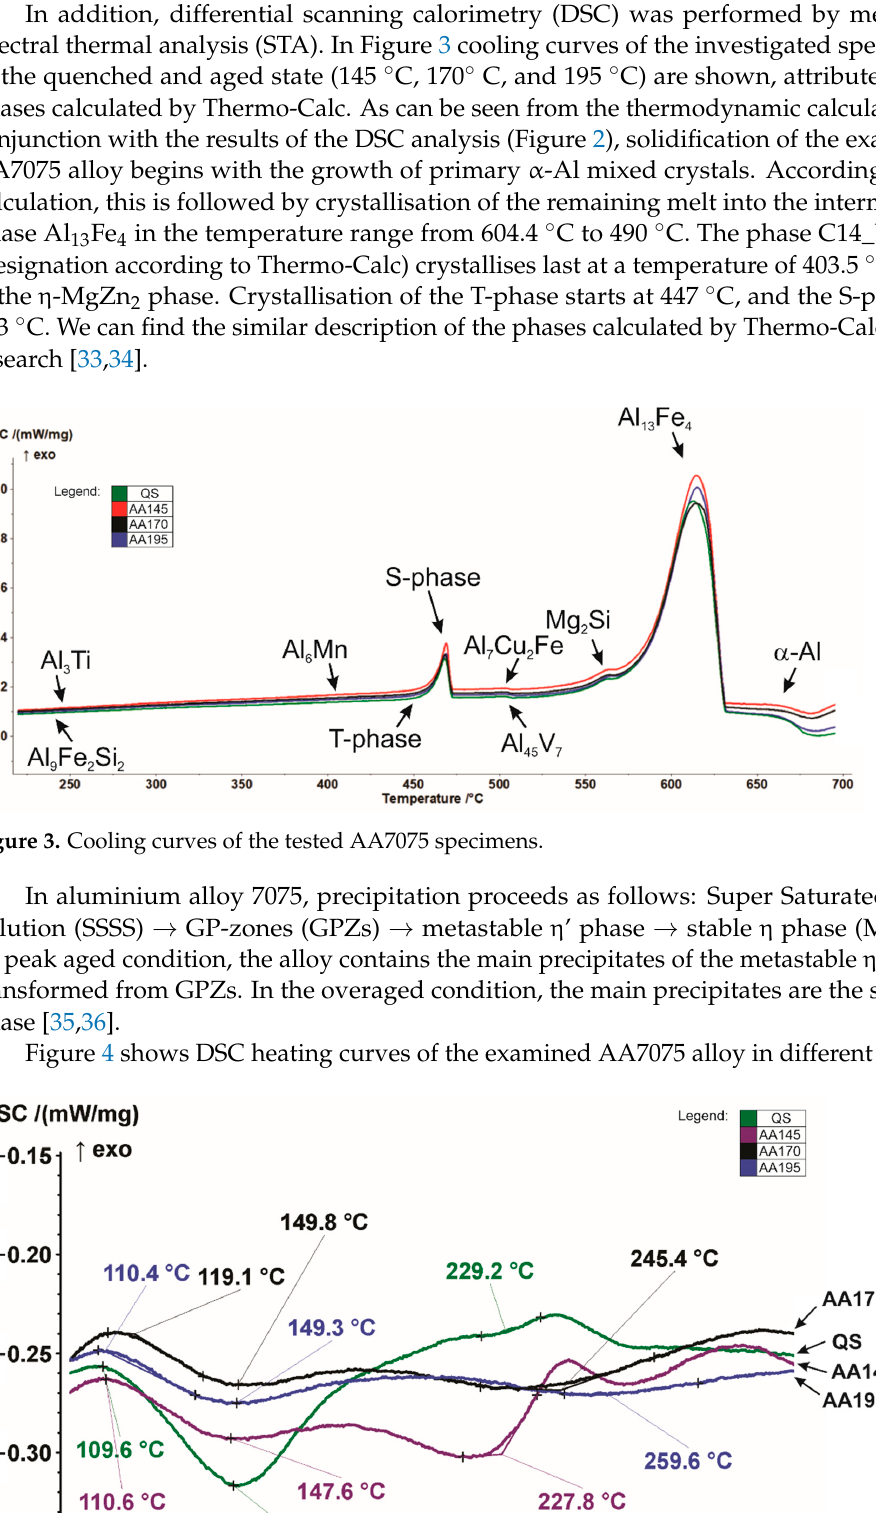
Figure 2. Proportion of phases as a function of temperature.